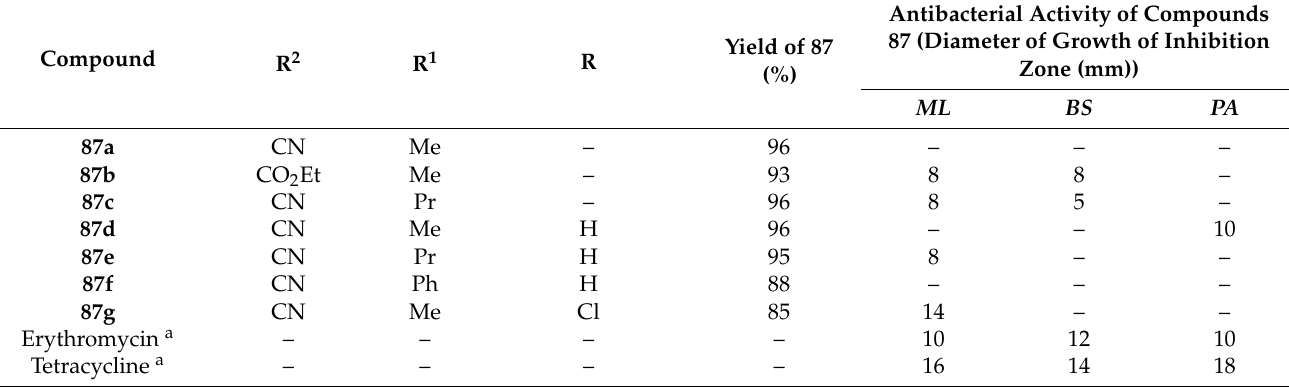
Table 22. Four-component synthesis of spiro-conjugated pyrano[2,3- c ]pyrazoles 87 and their in vitro antibacterial activity against three bacterial